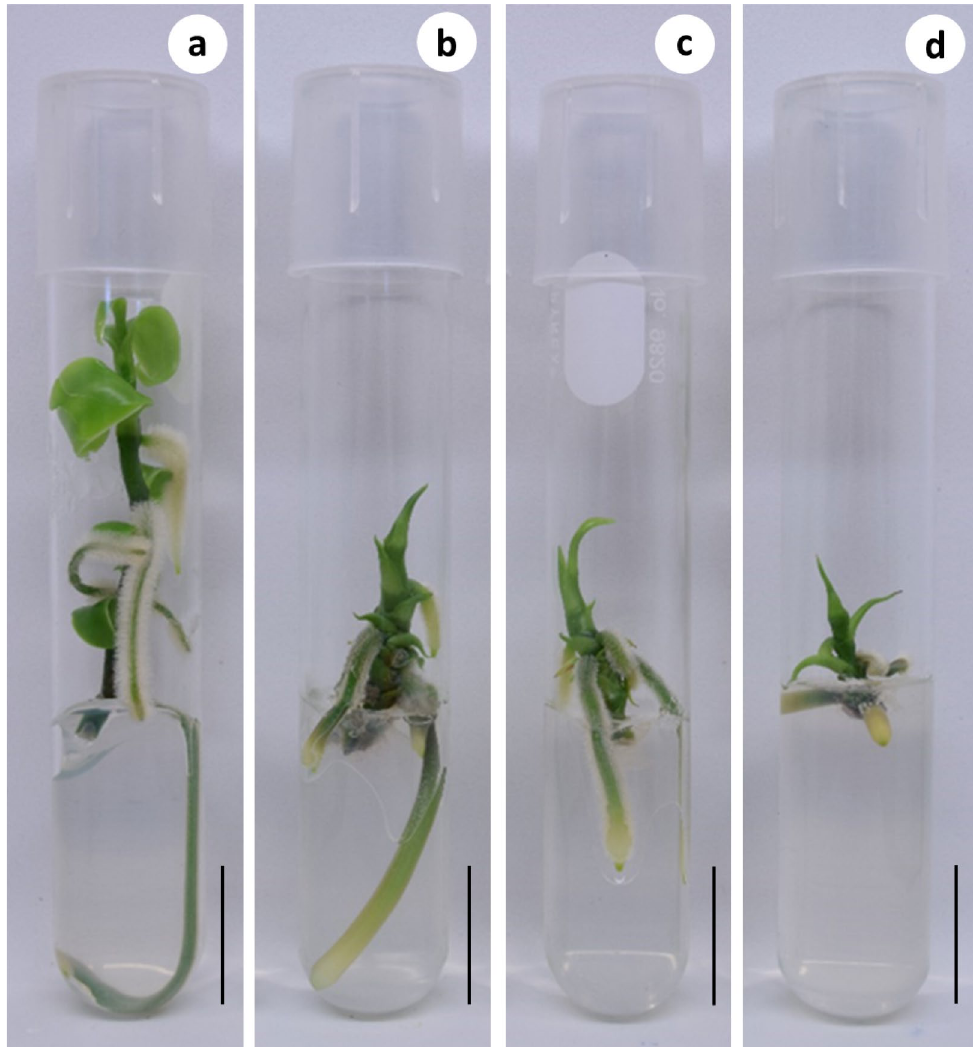
Figure 1. Effect of different concentrations of PEG 6000 on the growth of Vanilla planifolia at 60 days of culture. ( a–d ) 0, 1, 2 and 3% PEG 6000, respectively. Black bar = 2